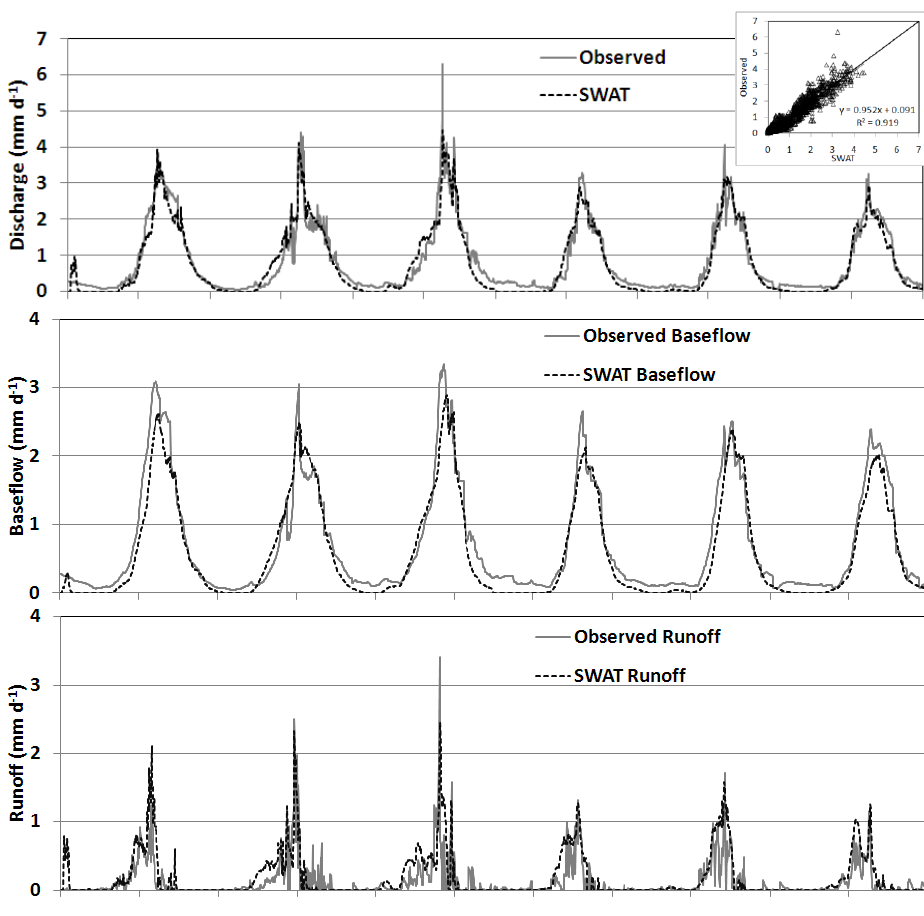
Fig. 4. Daily observed and predicted discharge, runoff, and baseflow at the Sudan